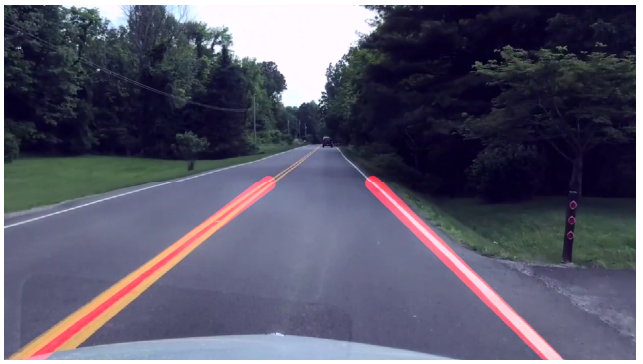
Figure 12. The highlighted lanes.